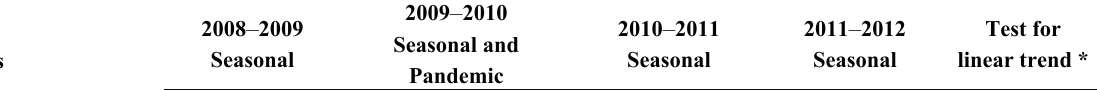
Table 2. Demographic characteristics and influenza vaccination rates from the 2008–2009 season to the 2011–2012